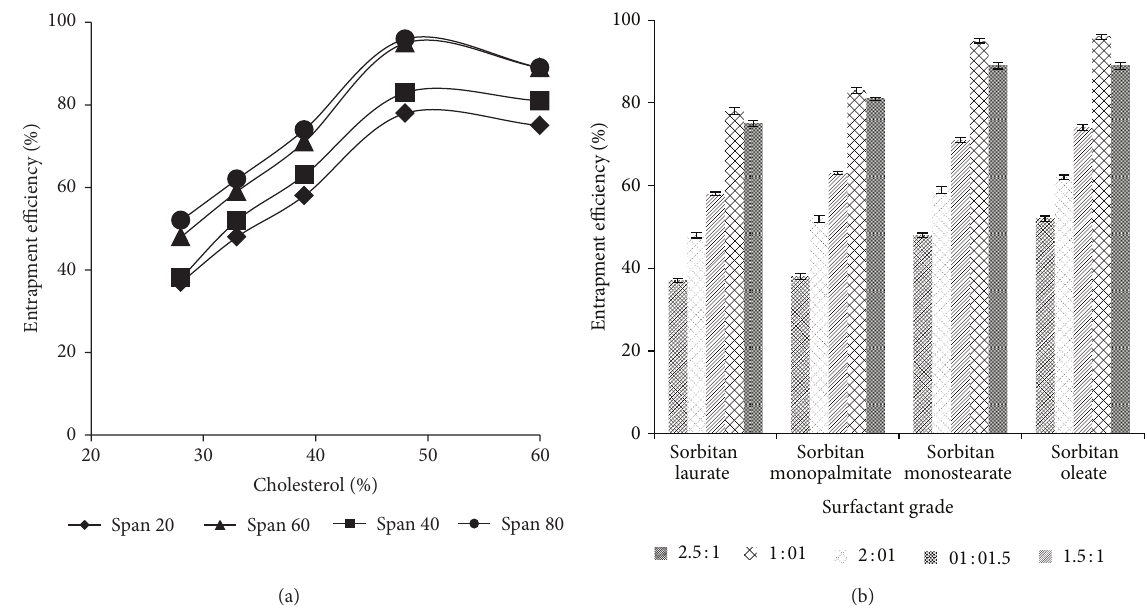
Figure 3: (a) % entrapment efficiency versus % CHOL indicating the effect of CHOL concentration on % entrapment efficiency, (b) % entrapment efficiency versus surfactant grades with several surfactant:CHOL